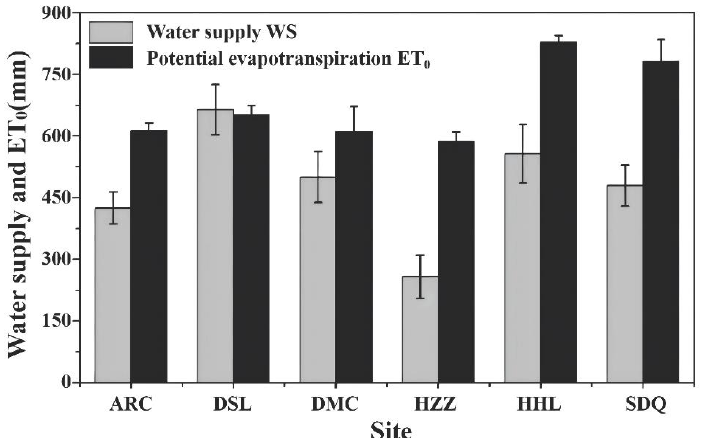
Figure 4. Water supply and potential ET of growing season for alpine meadow (ARC), alpines swamp meadow (DSL), cropland (DMC), Kalidium foliatum (HZZ), P. euphratica (HHL), T. ramosissima (SDQ) ecosystems of HRB.